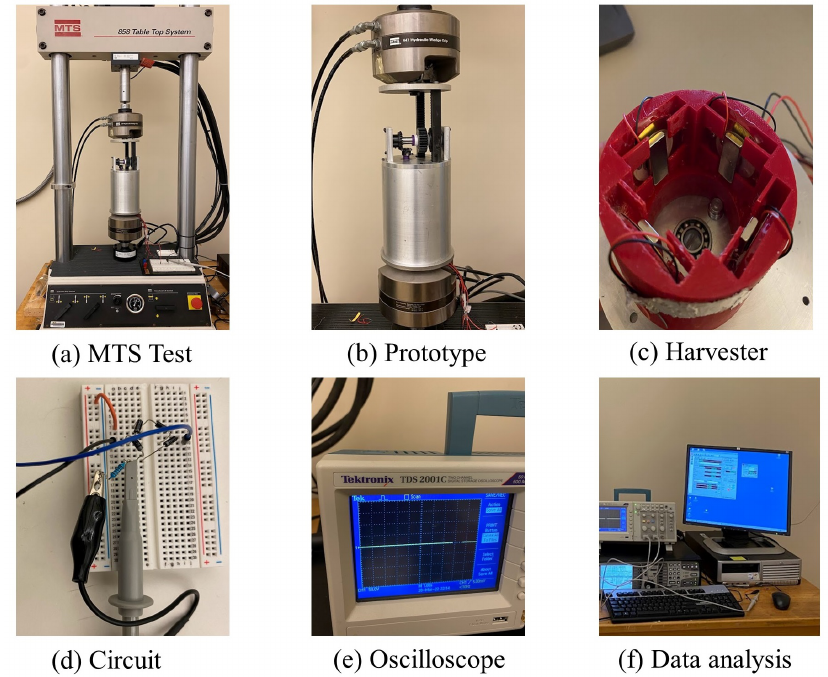
Figure 7. Bench tests of the presented regenerative suspension